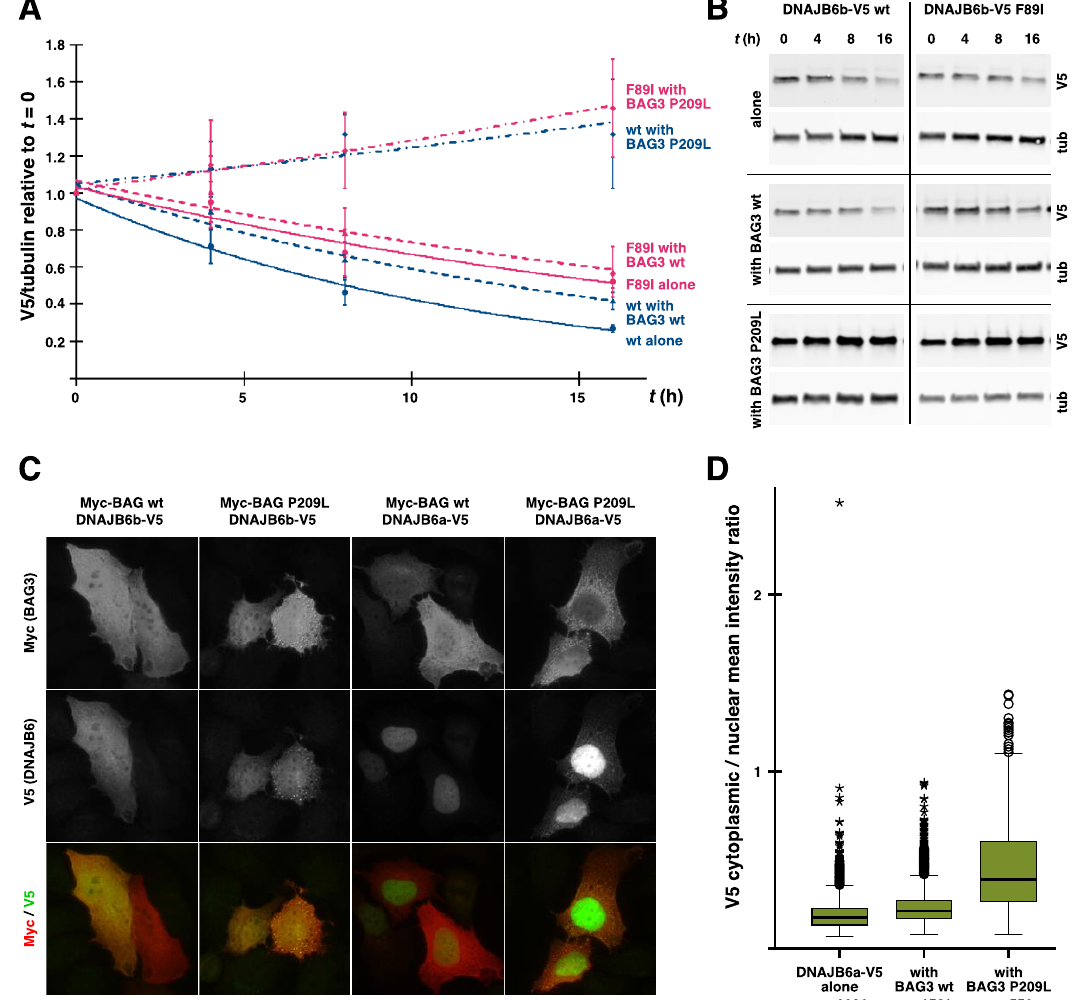
Figure 7. Effect of BAG3 p.P209L on DNAJB6. ( A ) Coexpression with BAG3 p.P209L similarly blocks the turnover of wild-type and p.F89I mutant DNAJB6b. Graph shows mean ± S.D. from 4–5 experiments performed in triplicate, with exponential trendlines fitted to the data points. ( B ) Representative Western blots showing DNAJB6b-V5 wt and p.F89I (V5) and tubulin (tub) levels at di ff erent time points. ( C ) Both DNAJB6a and DNAJB6b are recruited to cytoplasmic aggregates formed by BAG3 p.P209L in HeLa cells. ( D ) BAG3 p.P209L causes increased cytoplasmic localization of DNAJB6a in HeLa cells. Box plots show the cytoplasmic / nuclear V5 mean intensity ratio in n = 552–2291 cells per group.